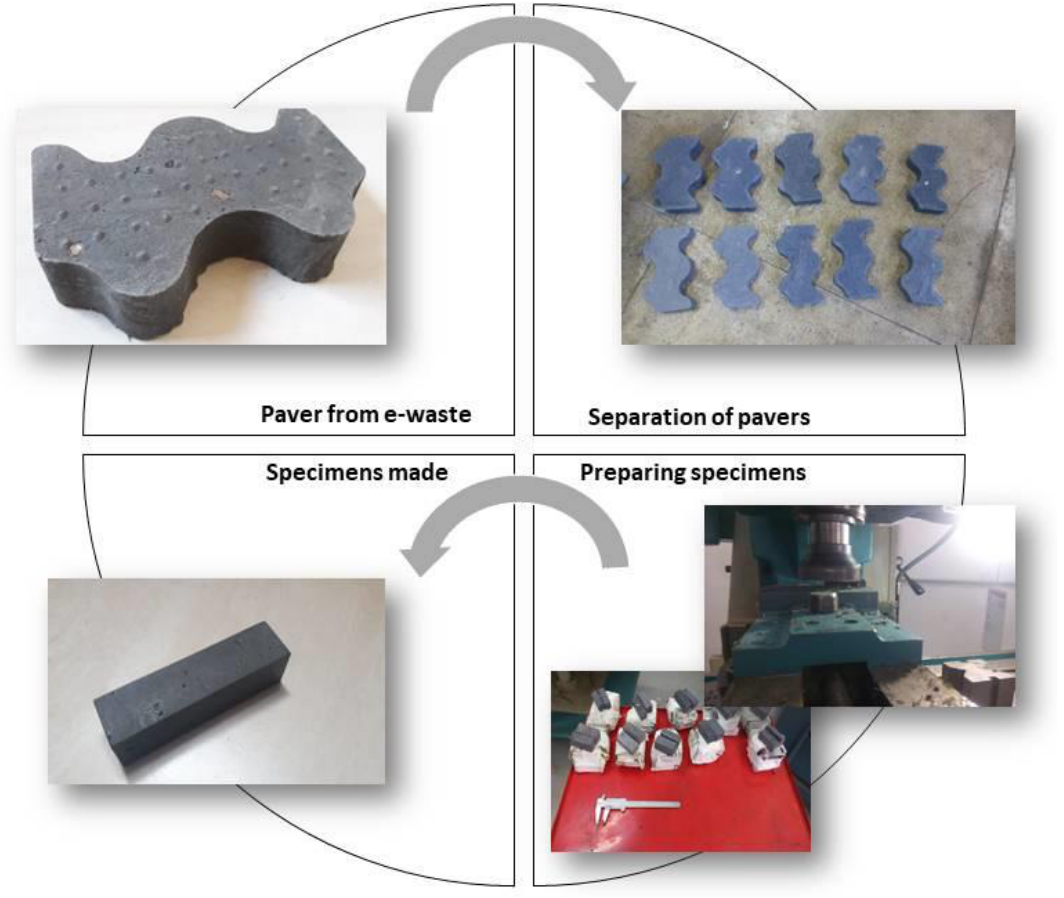
Figure 3. Separation of pavers and specimen preparation for essays.